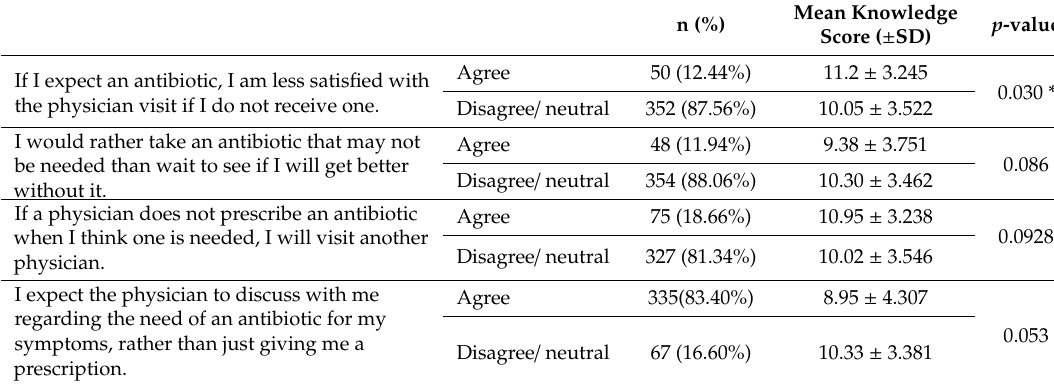
Table 4. Respondents’ mean knowledge score and expectation on antibiotic use (n = 402).